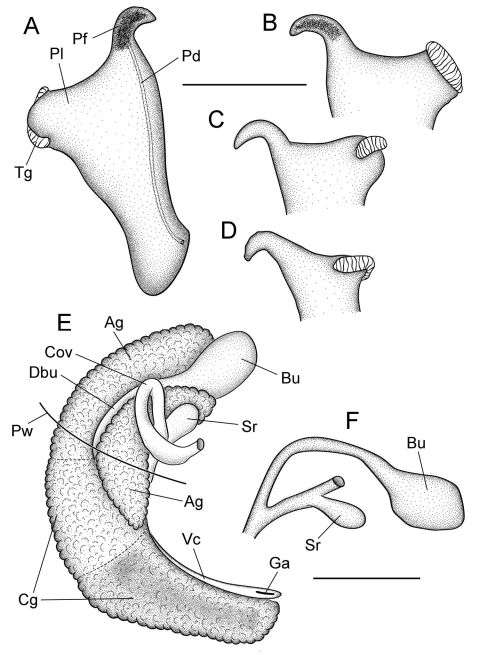
Reproductive anatomy, Marstonia comalensis, USNM 874926. A Penis, dorsal surface B–D Distal portion of penis showing terminal gland variation E Female glandular oviduct and associated structures (viewed from left side) F Bursa copulatrix and seminal receptacle and their ducts. Scale bars = 500 µm. Ag albumen gland Bu bursa copulatrix Cg capsule gland Cov coiled oviduct Dby bursal duct Ga genital aperture Pf penial filament Pl penial lobe Pw posterior wall of pallial cavity Sr seminal receptacle Vc ventral channel of capsule gland.